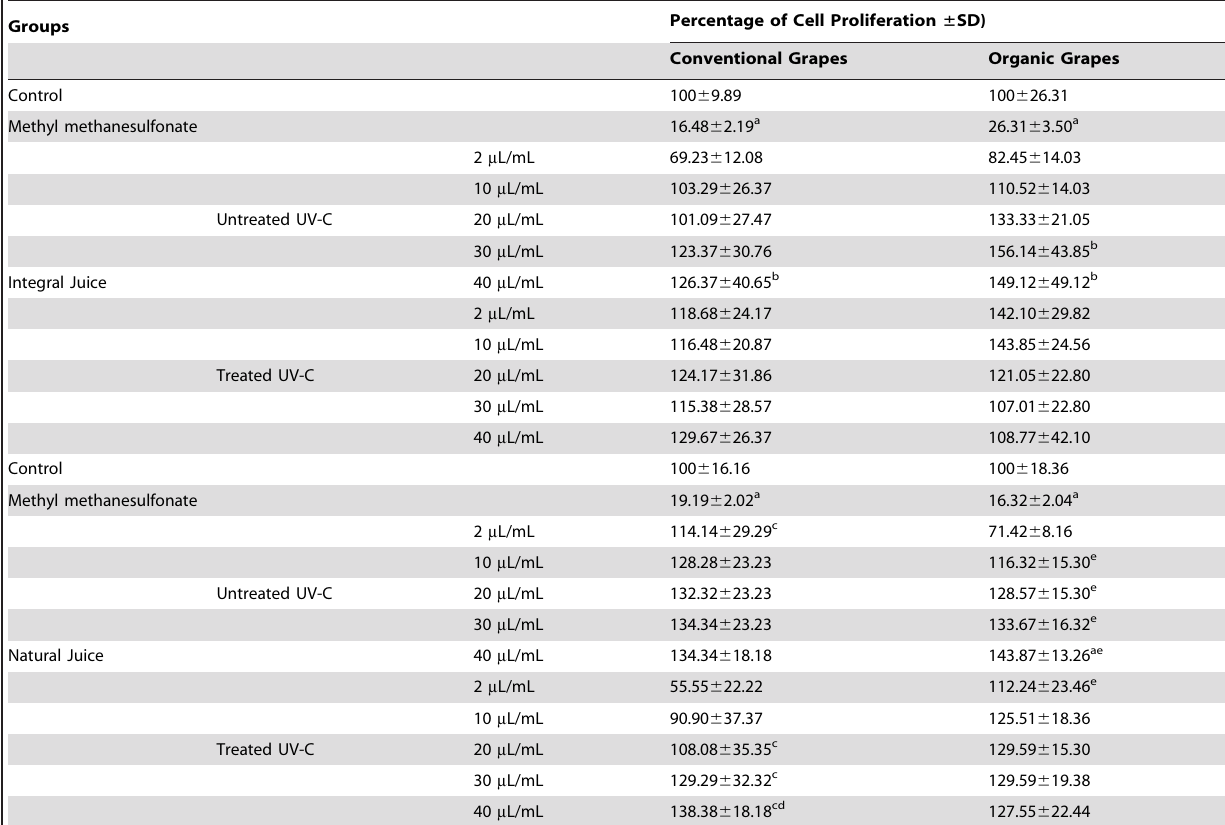
Table 1. Average value and standard deviation (SD) of the absorbance in the MTT cytotoxicity test using HTC cells treated with methyl methanesulfonate (150 m M) or integral and natural juices of conventional and organic grapes at concentrations 2, 10, 20, 30 and 40 m L/mL and untreated or treated with UV-C or the negative control group (20 m L PBS/mL).